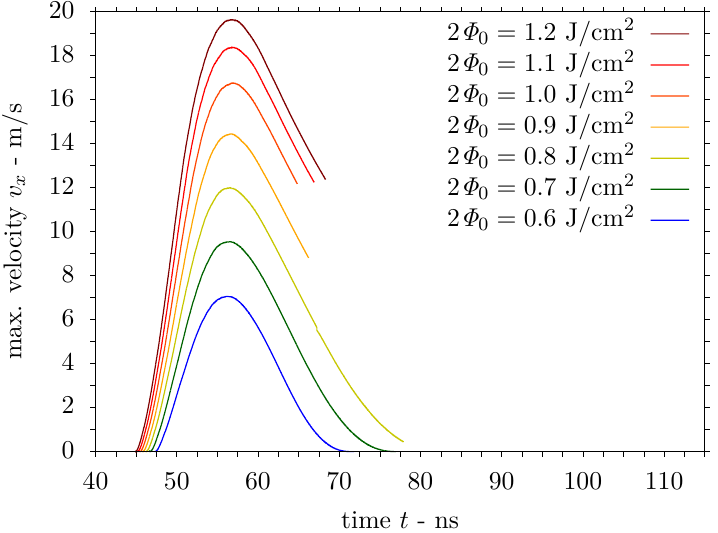
Figure 10. Maximum horizontal velocity magnitude below the melt pool surface as computed by SPH during DLIP of high-purity aluminium substrate for different laser